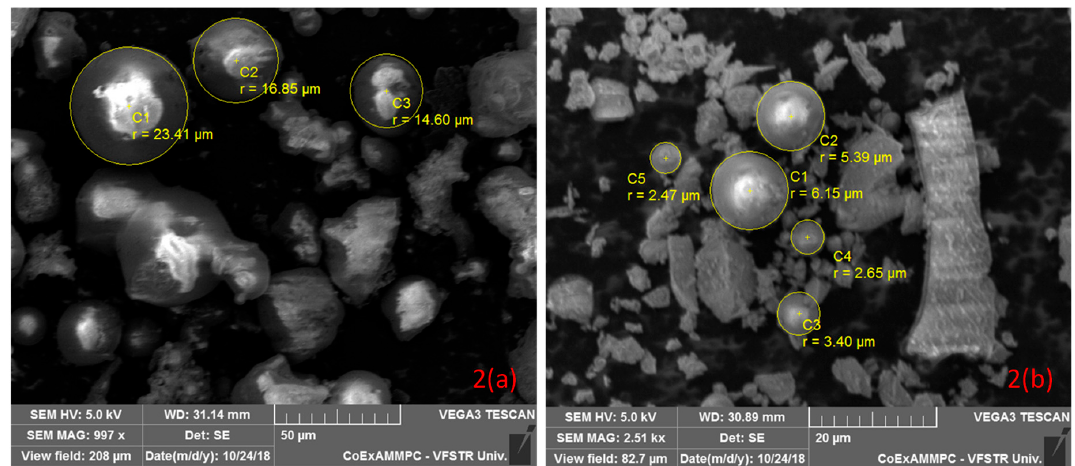
Figure 2. ( a ) Scanning electron microscope (SEM) image of fly ash at 50 µm, ( b ) SEM image of GGBFS at 20 µm.